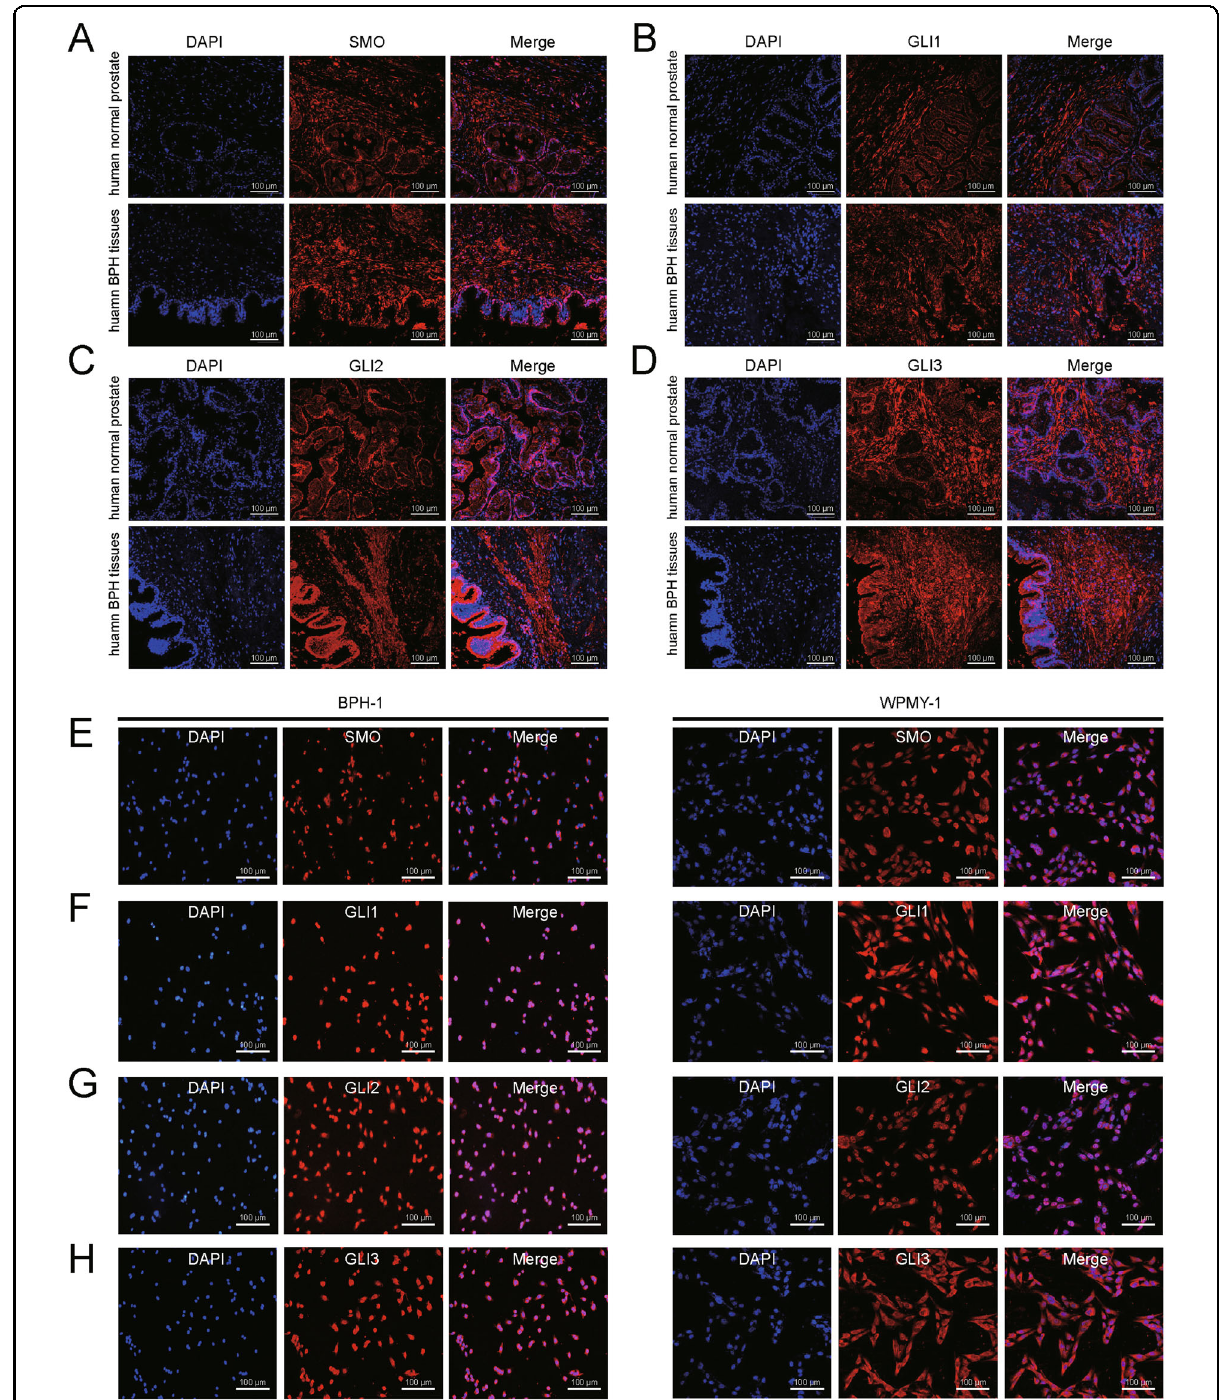
Fig. 2 Immuno fl uorescence localization of SMO and GLI family in human prostate tissues and human prostate cell lines. A – D Immunolocalization of SMO, GLI1, GLI2, and GLI3 for normal human prostate (above) and BPH prostate (below). E – H Immuno fl uorescence of SMO, GLI1, GLI2, and GLI3 in BPH-1 and WPMY-1 cells. The scale bars are 100 μ